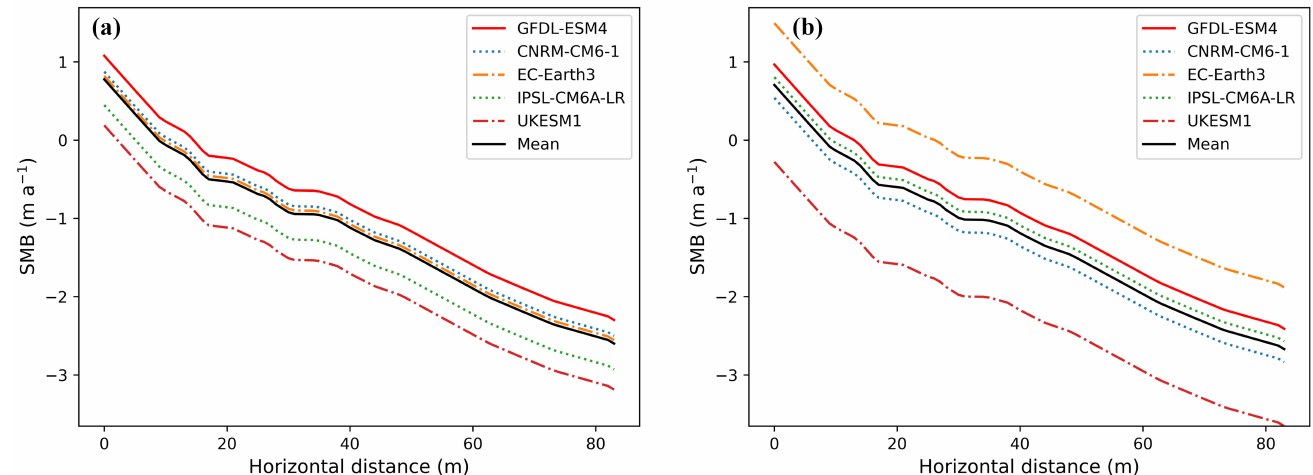
Figure 11. Parameterization of the SMB for different global climate models under SSP1-2.6, ( a ) in 2060 and ( b ) in 2100. The global climate models include GFDL-ESM4, CNRM-CM6-1, EC-Earth3, IPSL- CM6A-LR, and UKESM1. The climate model used for the SMB parameterization in this study is GFDL-ESM4 (red solid line); the black solid line is the mean SMB of different global climate